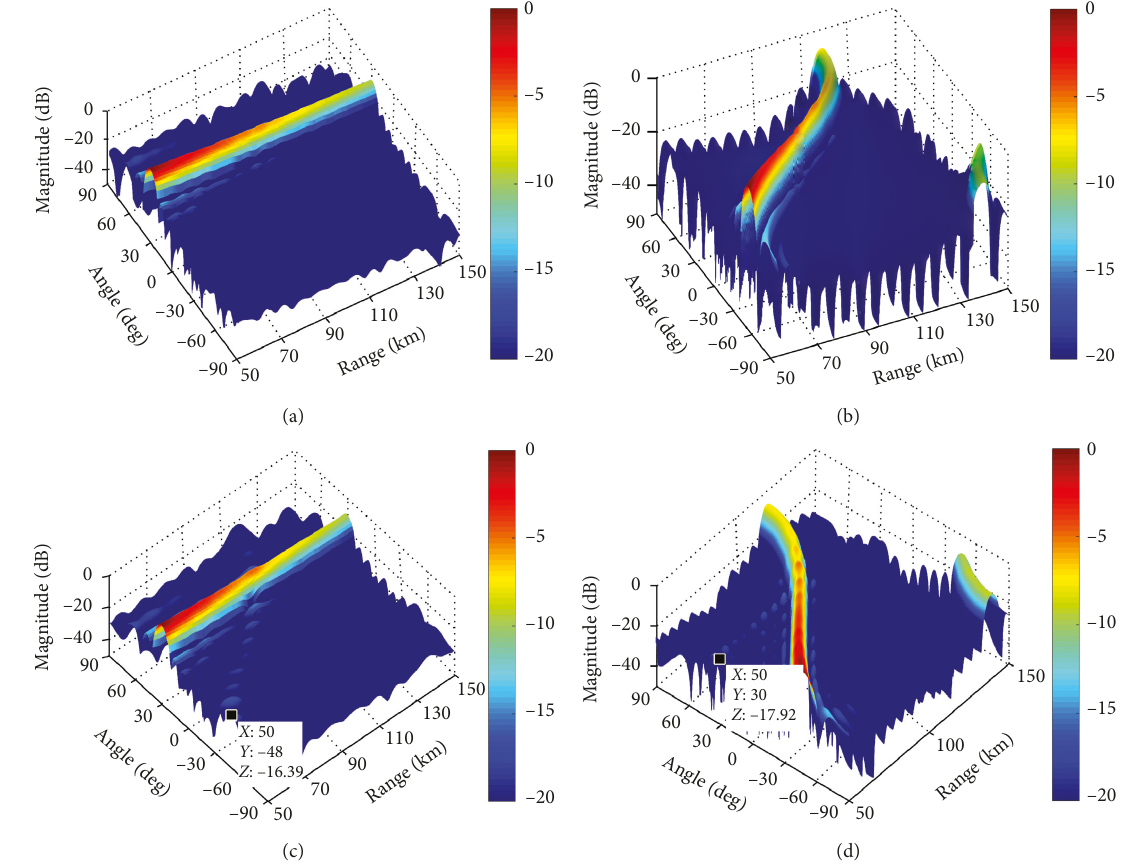
Figure 4: Snapshots of one-way normalised radiation pattern at t � 4/ Δ f , θ � 30 ° for (a) K